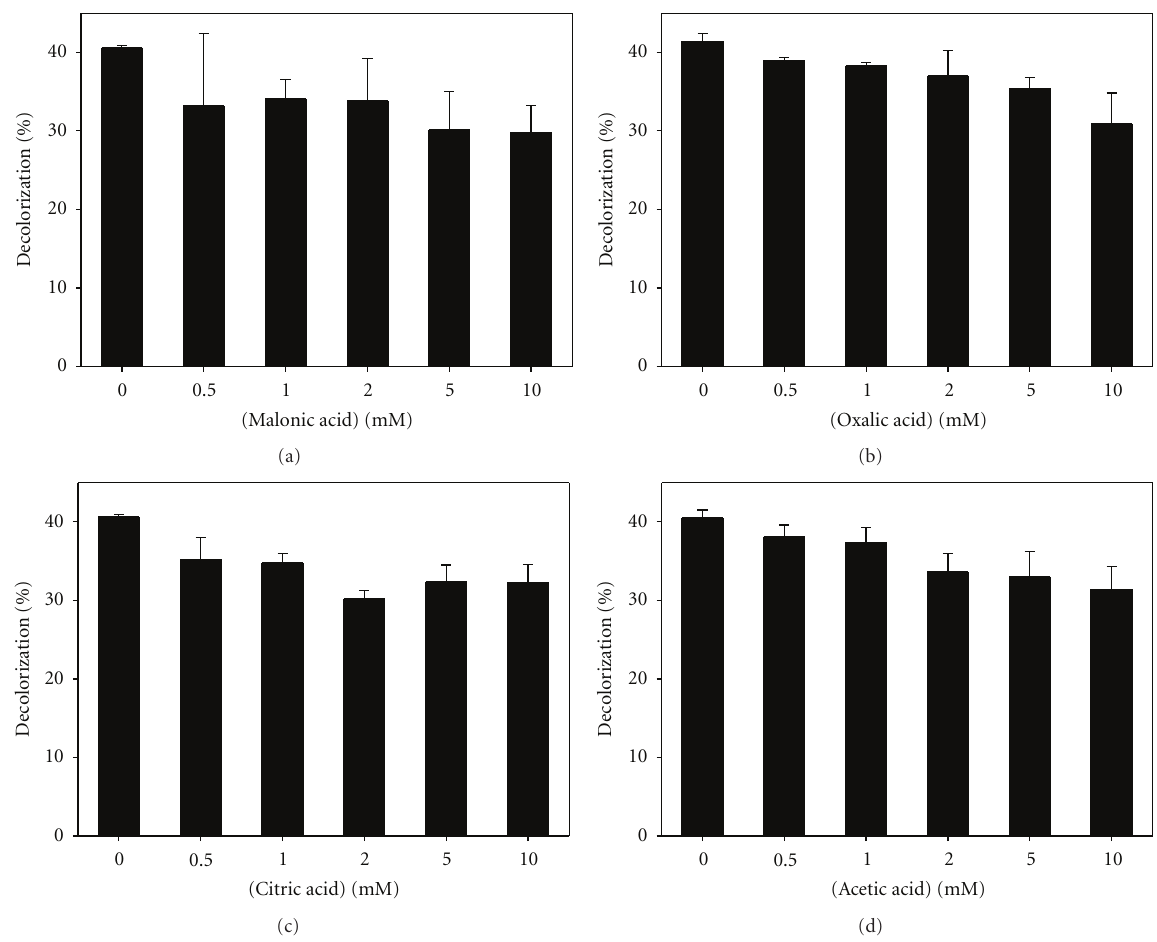
Figure 6: Decolorization of CV dye by laccase in presence of organic acids: malonic (a), oxalic (b), citric (c), and acetic (d) acids.